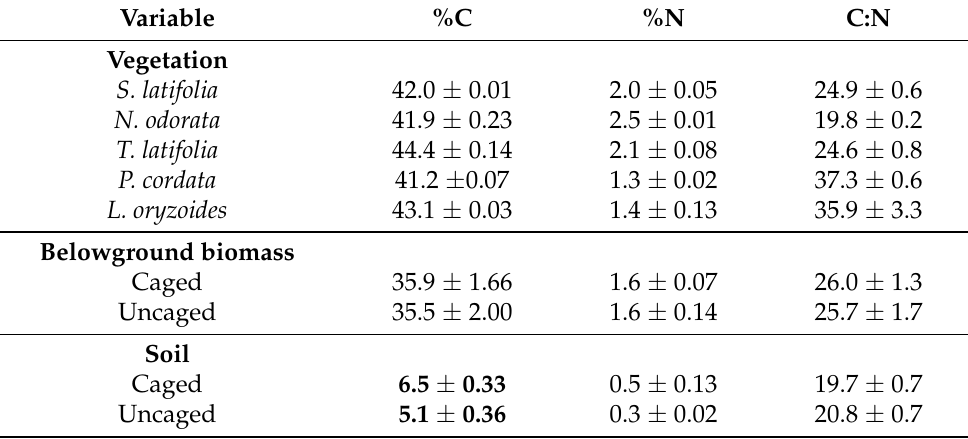
Table 2. Elemental composition of dominant plant species at the study site and belowground biomass and soil from caged and uncaged plots, mean ± SE. Bold values indicate significant differences betwen caged an uncaged